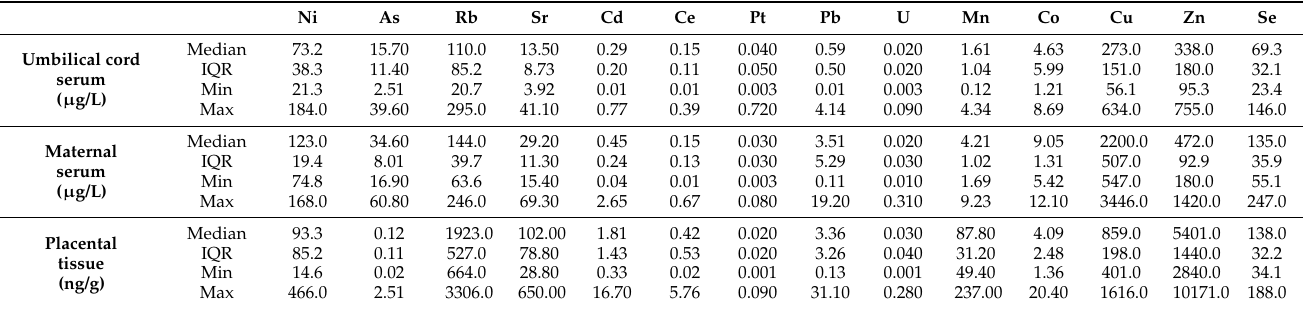
Table 1. Median, interquartile range (IQR), and minimum (min) and maximum (max) levels of the toxic and essential metals in the analyzed clinical samples.